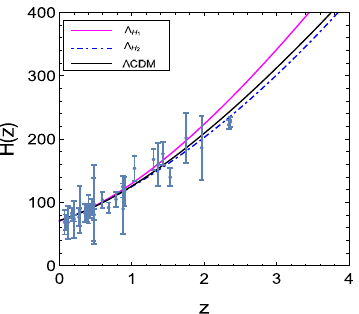
Fig. 7 Variation of the Hubble function as a function of the redshift z forthebest-fitvalueofthemodelsusingDS1dataset.Theobservational 36 H ( z ) points are shown with error bars (grey colour). The variation of the Hubble function in the standard Λ CDM model is also